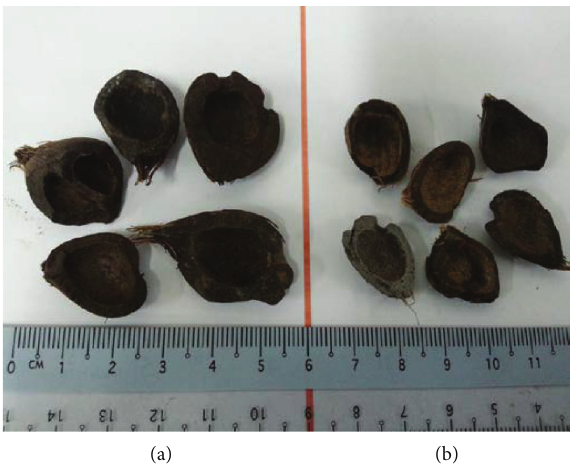
Figure 1: Original dura (a) and tenera (b) OPS